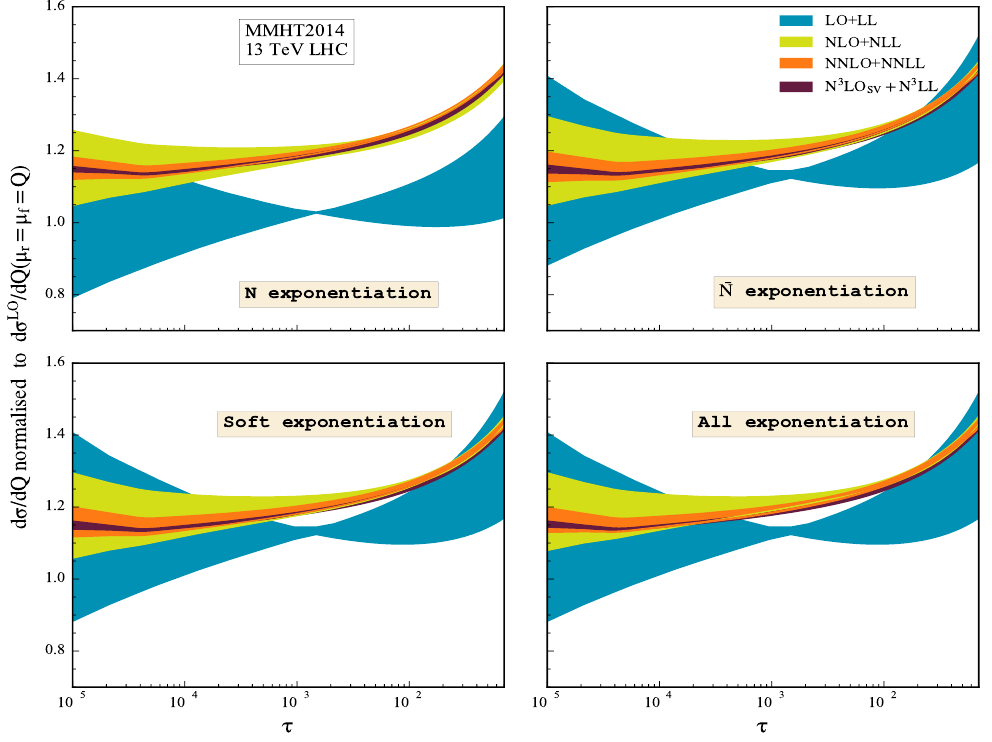
Figure 6 . 7-point scale variations around the central scale choice ( (cid:22) r = Q; (cid:22) f = Q ) are presented as in (cid:12)gure 2 but for resummed predictions up to N 3 LL